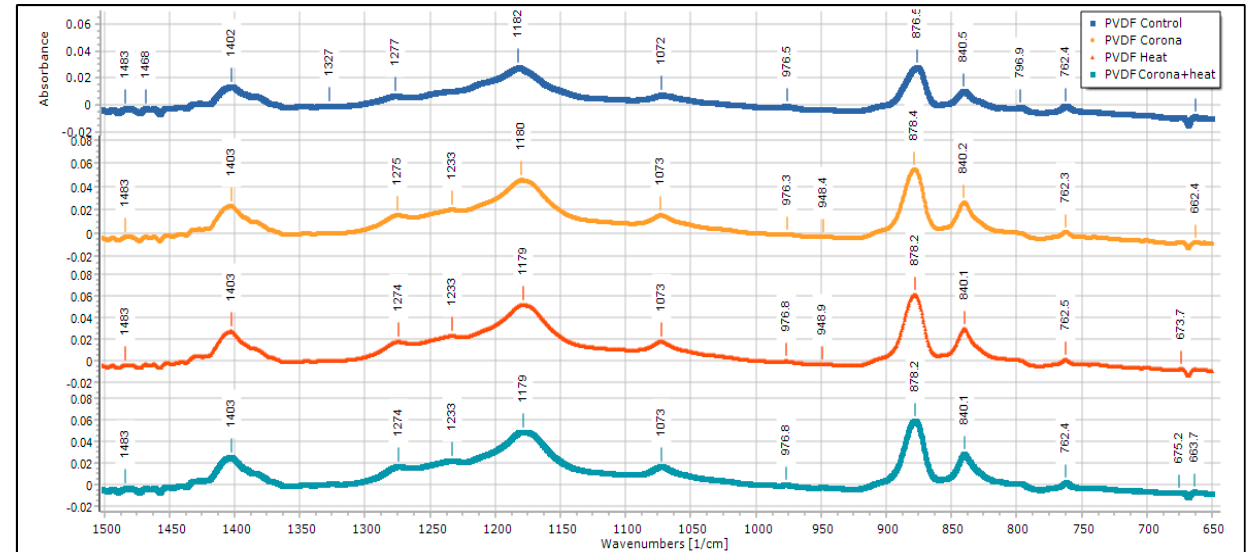
Figure 11. FTIR of pristine PDVF membrane .